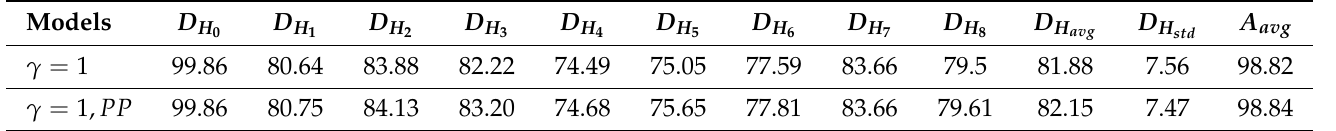
Table 6. Results for the models trained with the Dice loss, which corresponds to the case of γ = 1 for all the previously defined focal Dice losses. Comparisons for the different liver segments. PP stands for Post-Processing. D H is the “hard” Dice coefficient for class t . It is reported as a percentage. t D H is the arithmetic mean of D H . D H is the standard deviation of D H avg t std denoted as A avg